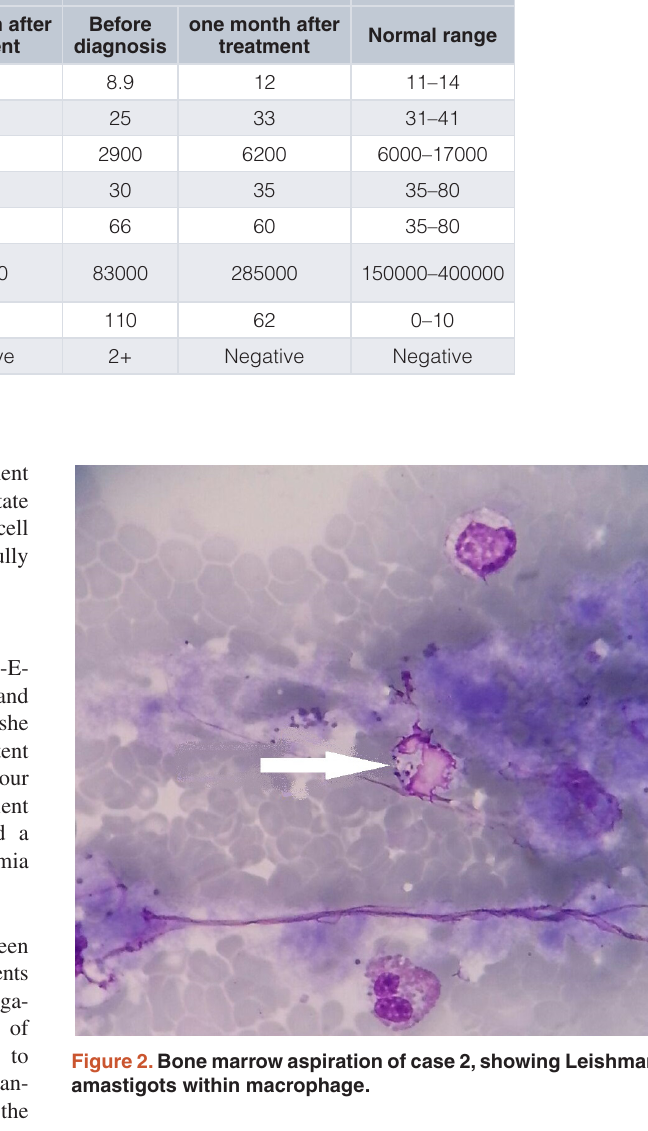
contamination of dogs in rural districts of Ghahan, a northwestern part of the province 7